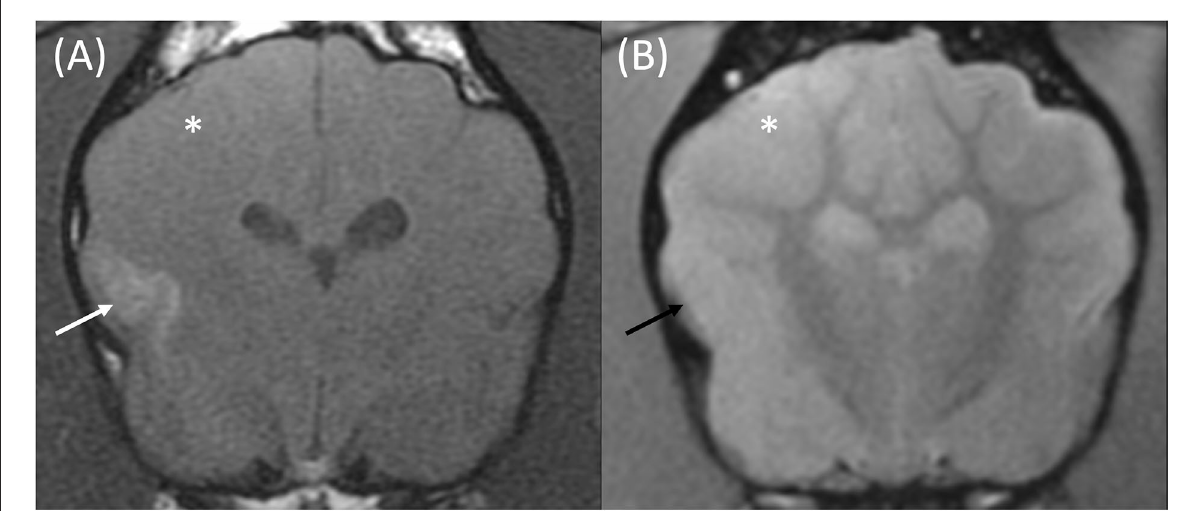
FIGURE2 Transverse T1w pre-contrast (A) and T2*w GE (B) images at the level of the caudate nuclei in an 8-month male entire French Bulldog that presented with acute onset generalized seizures. The MRI was performed 24h following the observed seizures. These findings are compatible with an ischemic stroke of the right middle cerebral artery. The T1w pre-contrast image (A) demonstrates a poorly defined T1w hyperintense signal affecting the cortical gray matter of the suprasylvian gyrus and pseudosylvian fissure (white arrow). No signal void is seen on the corresponding T2*w GE sequence ( B , black arrow). The gray matter of the right parietal and temporal lobes is swollen, and the gyri are effaced on both sequences (white asterisk).